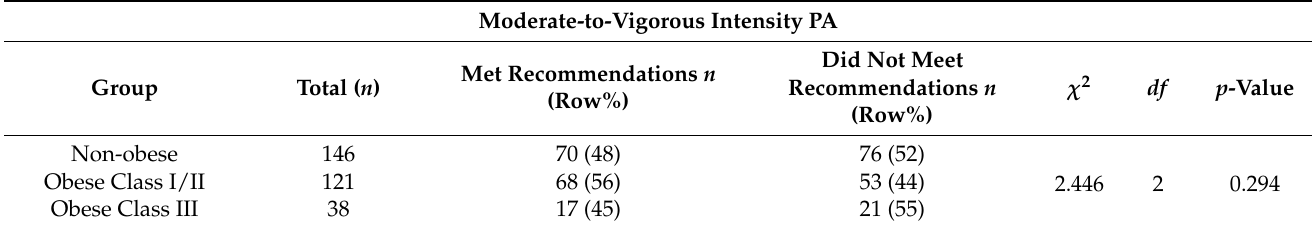
Table 3. Crosstabulations and chi-square tests for three-level BMI and meeting PA